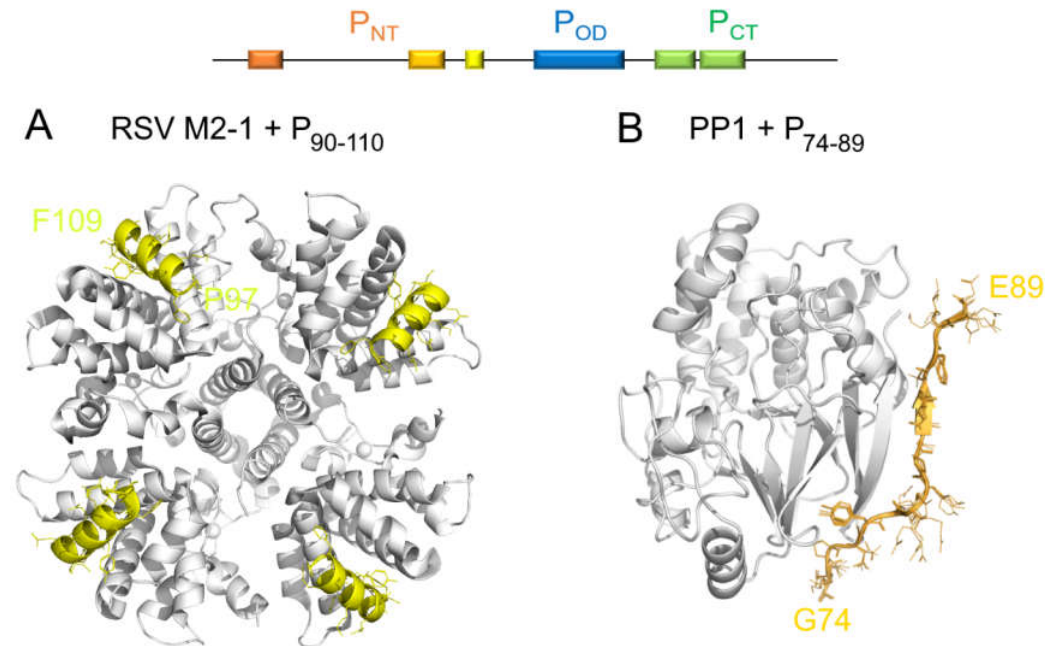
Figure 7. Stabilization of the structure of two short linear motifs (SLiMs) in RSV P protein, located in the N -terminal domain, upon complex formation. ( A ) X-ray structure of the hRSV M2-1–P complex, where a short transient helix, P residues P97–F109, is stabilized (PDB 6G0Y) [90]. ( B ) Homology model of the complex between the RVxF-like motif of P and cellular protein phosphatase 1, built with Modeller software [91]. The model was obtained by using the X-ray structure of the complex between the catalytic unit of PP1 and another PP1-binding protein, Gadd34 (PDB 4XPN), and by aligning the RVxF-like motifs of P and Gadd34. P fragments are shown in cartoon and lines. The color code is given in the scheme on top of the figure. The partner proteins are represented in the white cartoon.